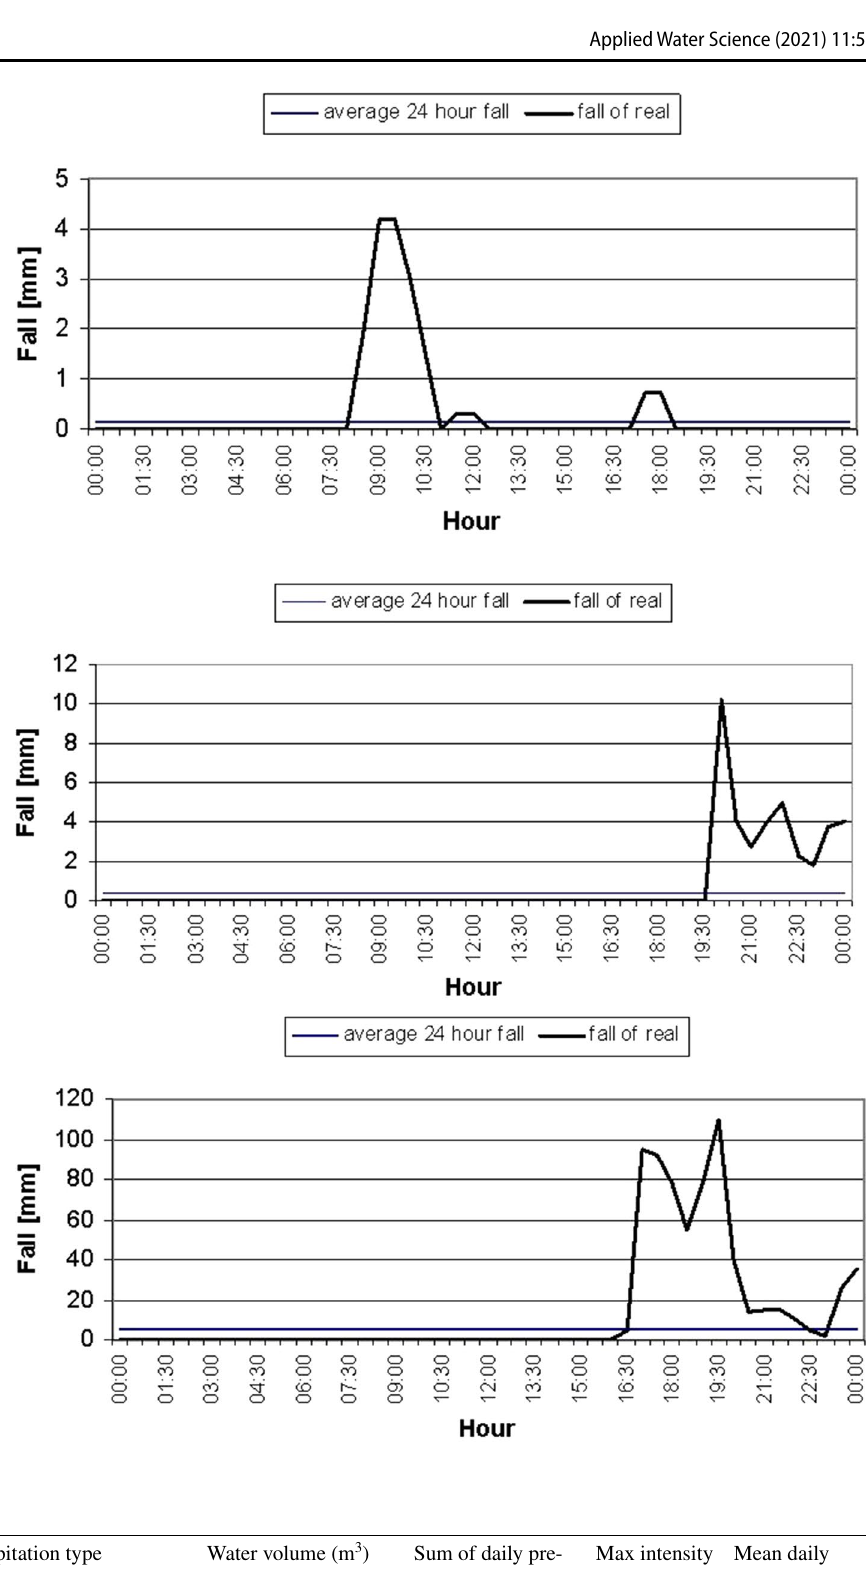
Table 1 Water quantity in plateau part of catchment depending on precipitation